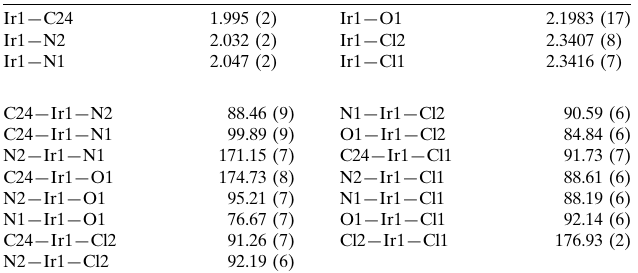
Selected geometric parameters (A˚ , (cid:2)